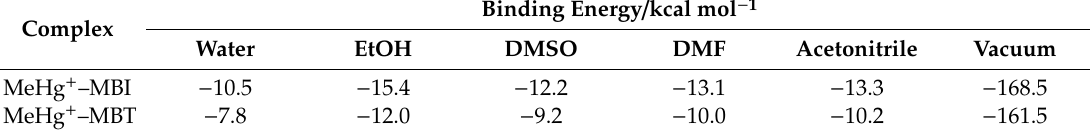
Table 1. Solvent e ff ect on binding energy in MeHg + complexes. The dielectric constant values for water, EtOH, dimethyl sulfoxide (DMSO), dimethylformamide (DMF) and acetonitrile were 78.4, 24, 47, 36.7 and 36.5, respectively. Binding Energy / kcal mol − 1 Complex Water EtOH DMSO DMF Acetonitrile Vacuum MeHg + –MBI − 10.5 − 15.4 − 12.2 − 13.1 − 13.3 − 168.5 MeHg + –MBT − 7.8 − 12.0 −